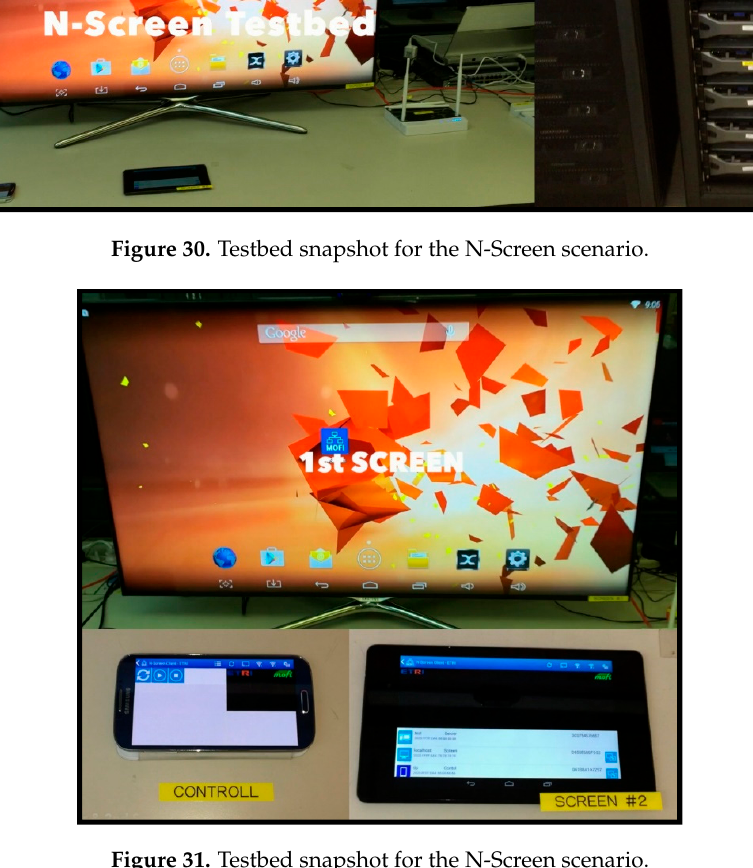
Figure 33. N ‐ Screen scenario. 6. Conclusions In this article, we presented a new mobility management architecture for a future mobile network. The new architecture features the separation of data and control planes, as well as a novel distributed HID–LOC mapping control. We implemented the architecture using OpenFlow and Click